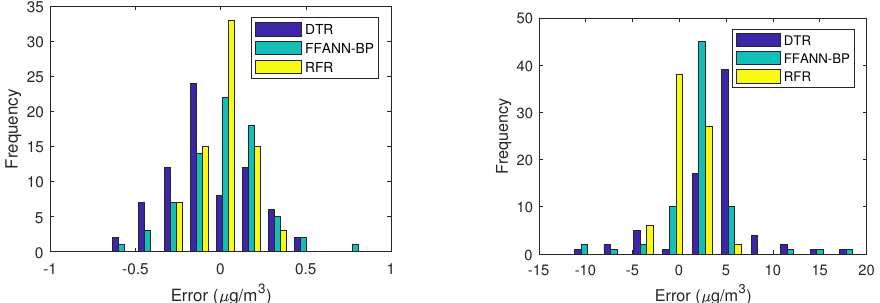
Figure 10. The error histogram of the prediction for CO and NO 2 at Ma Lian Kou.